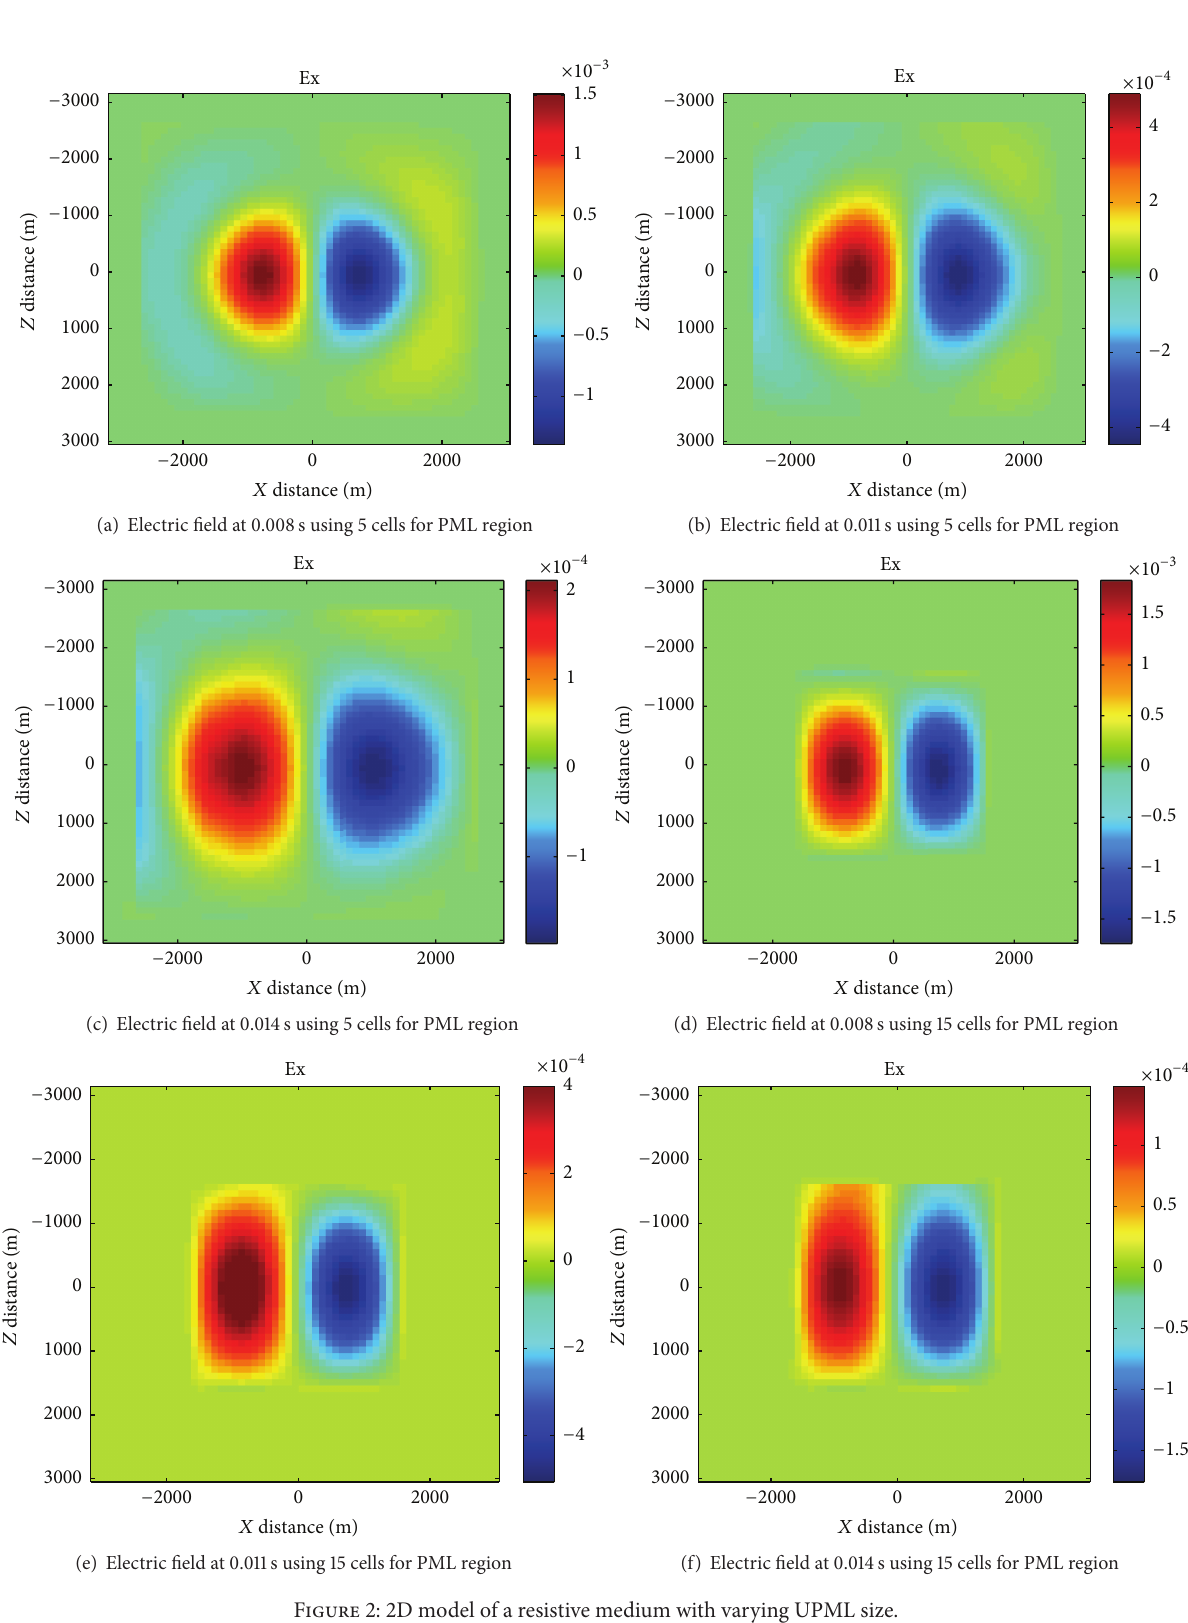
Figure 2: 2D model of a resistive medium with varying UPML